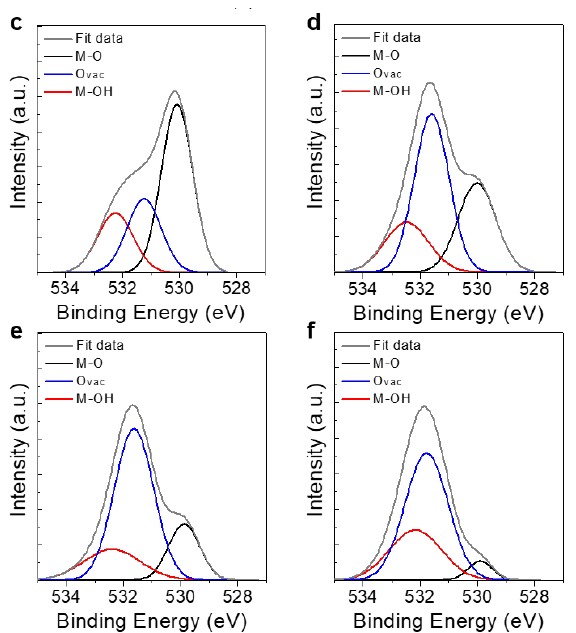
Figure 2. ( a ) Sheet resistance variation of IGZO films as a function of Ar plasma time. ( b ) The change in metal–oxygen (M-O), oxygen vacancy (O vac ), and metal hydroxide (M-OH) binding states in IGZO films as a function of Ar plasma time. O 1s peaks obtained from IGZO films with Ar plasma time of ( c ) 0 s, ( d ) 30 s, ( e ) 60 s, and ( f ) 180 s.